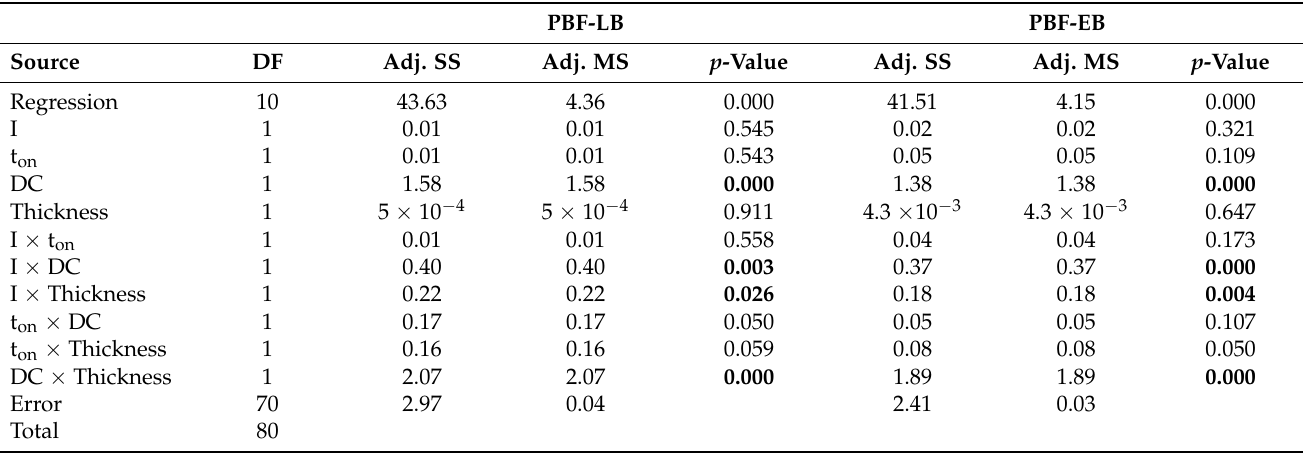
Table 7. ANOVA table of process parameters and their interactions for cutting speed V c in the case of the PBF-LB and PBF-EB processes (significant factors or interactions are highlighted in bold).